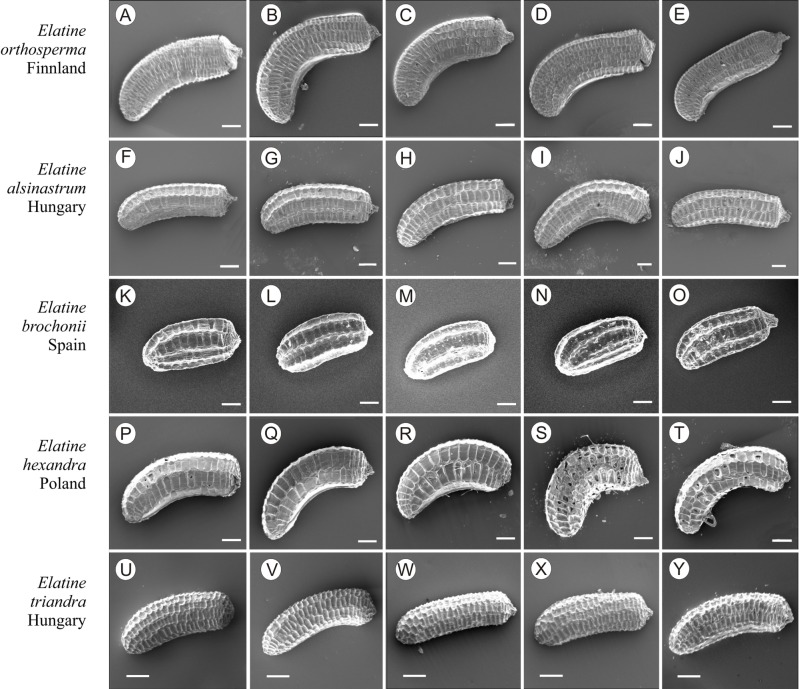
The diversity of seeds of Elatine orthosperma, E. alsinastrum, E. brochonii, E. hexandra, E. triandra.Scale bar =200 µm. (A–E) E. orthosperma; (F–J) E. alsinastrum; (K–O) E. brochonii; (P–T) E. hexandra; (U–Y) E. triandra.